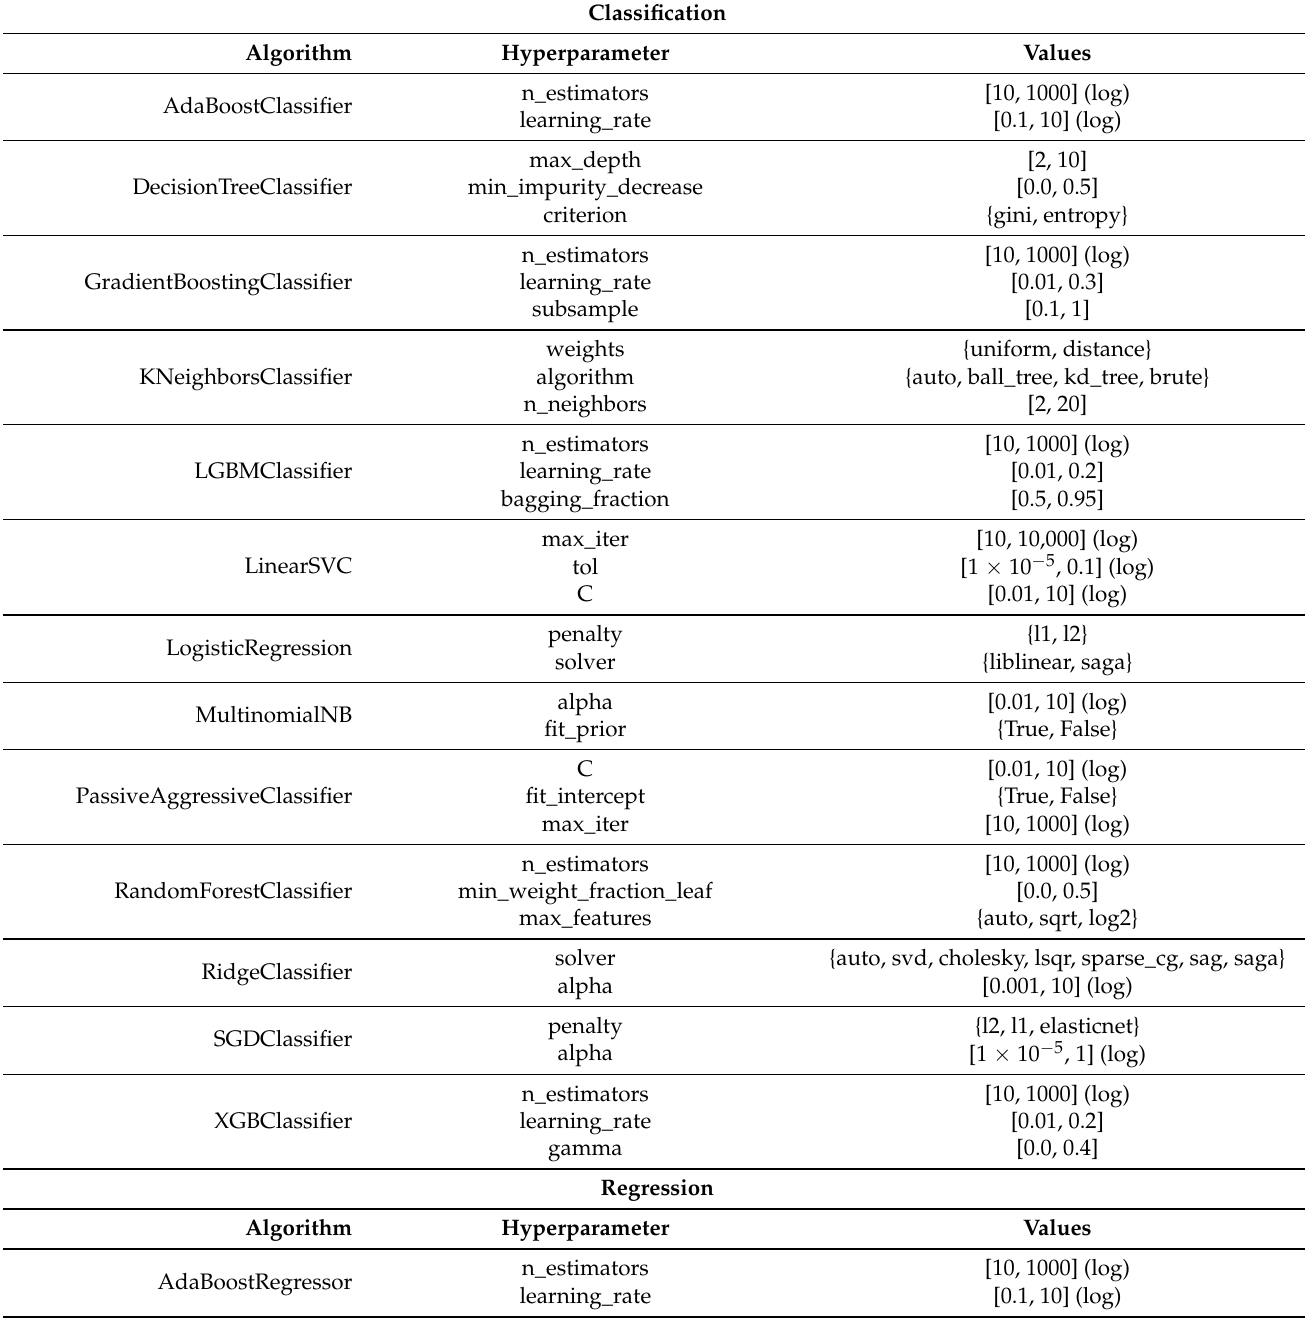
Table 1. Value ranges or sets used by Optuna for hyperparameter tuning. For ease of reference, we use the function names of the respective software packages: scikit-learn, xgboost, and lightgbm. Values sampled from a range in the log domain are marked as ‘log’, otherwise sampling is linear